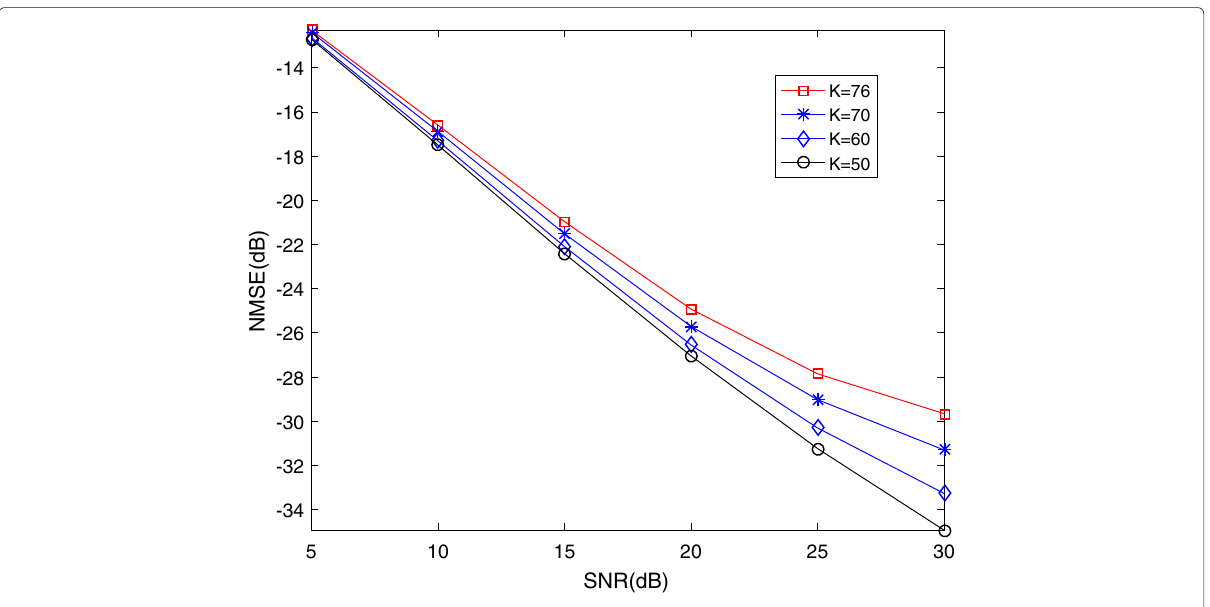
Fig. 6 NMSE of 2D-SL0-CE with various numbers of users